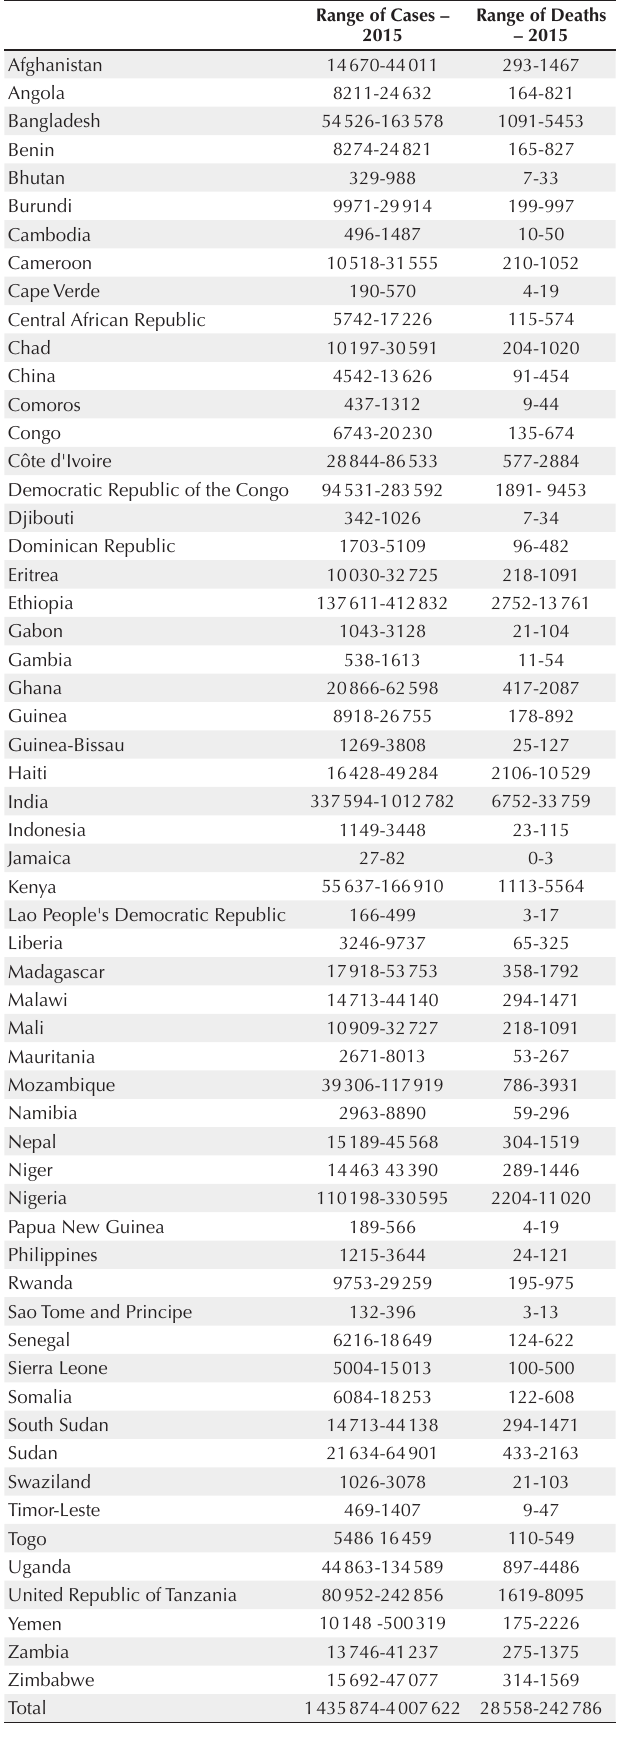
Table 1. Cholera Burden in High Prevalence Countries,